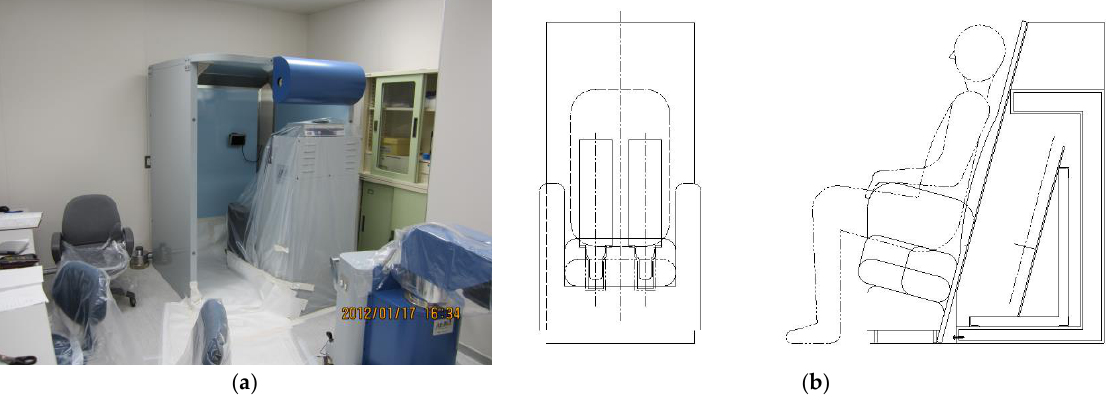
Figure 1. ( a ) Chair-type whole body counter at Fukui Prefectural Hospital. ( b ) Schematic drawings of the two NaI(Tl) detectors aligned alongside and horizontally in the chair.